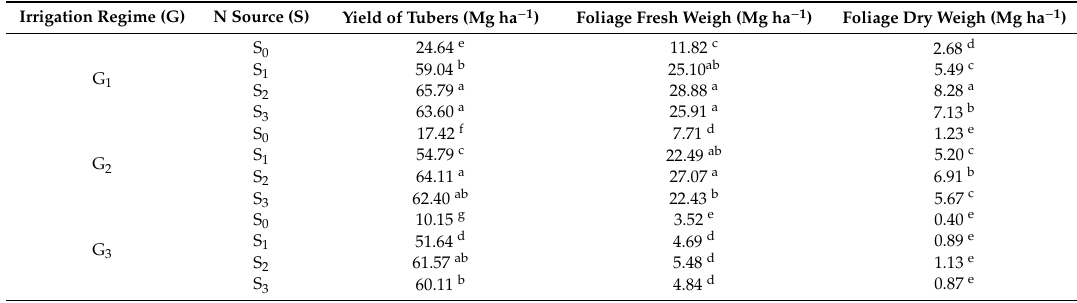
Table 5. Tubers and foliage yields of potato (Mg ha − 1 ) as a ff ected by drip irrigation regime and N source